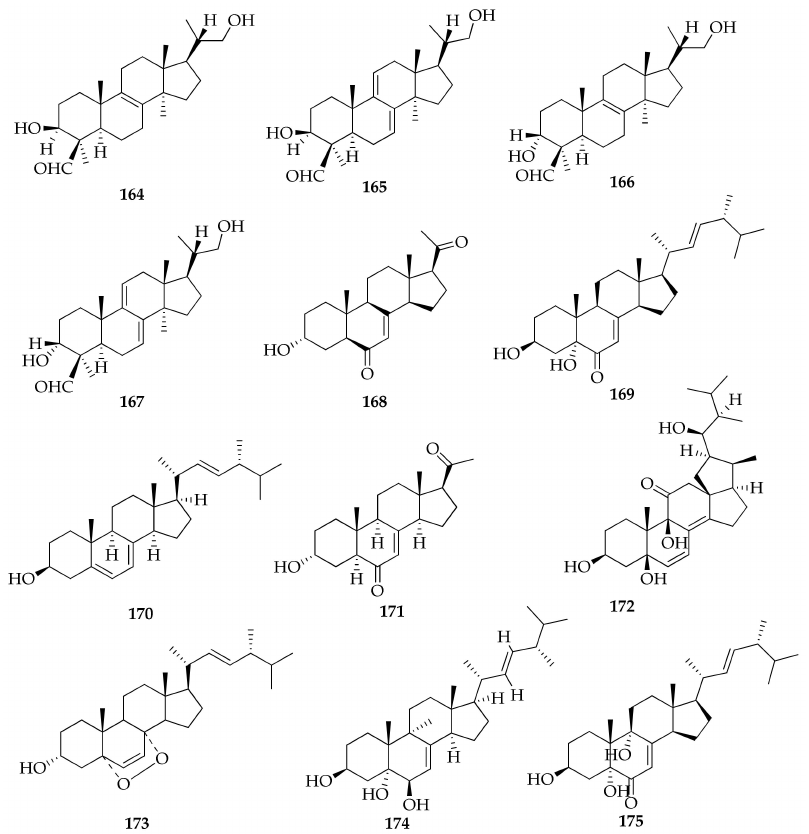
Figure 26. Structures of